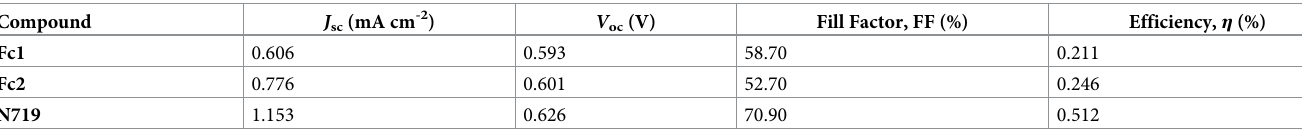
Table 6. Summary of the photovoltaic parameters of the DSSC